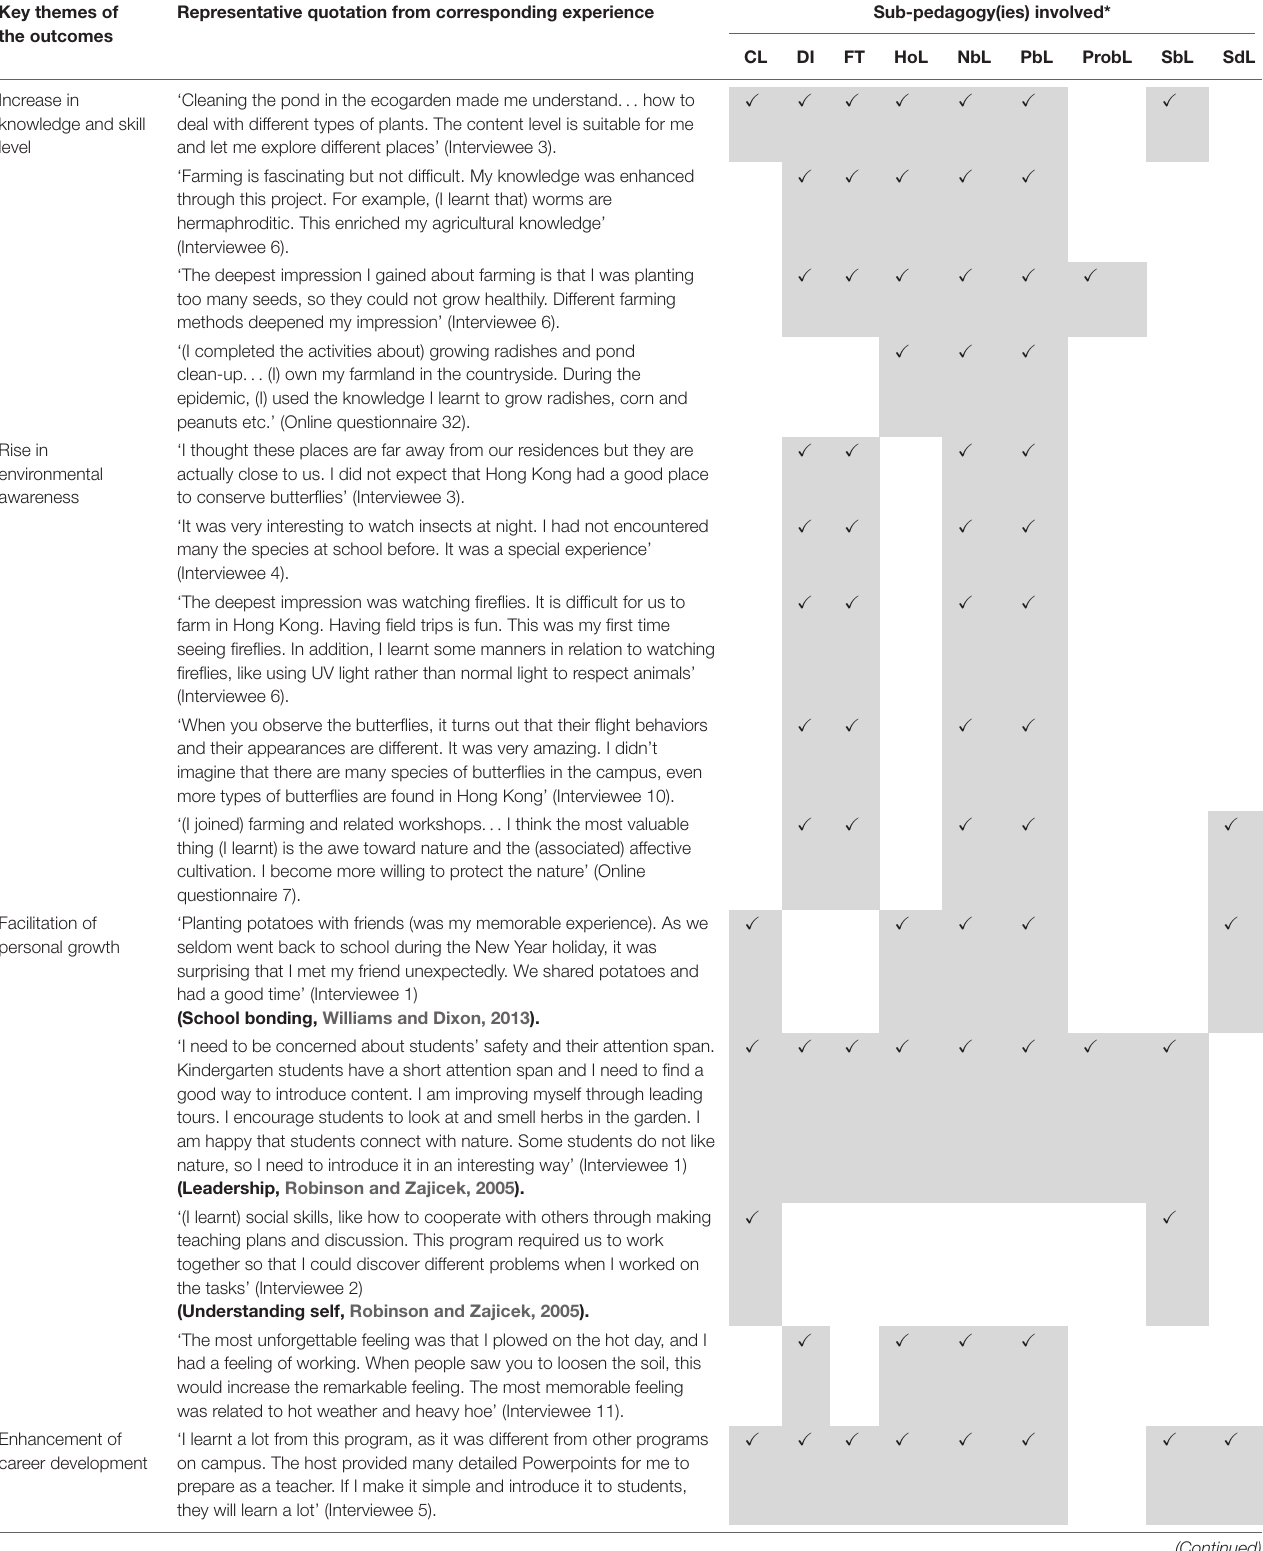
TABLE 1 | The exemplary quotes from the themes identified in the study with the associating sub-pedagogies being matched. Key themes of Representative quotation from corresponding experience Sub-pedagogy(ies) involved* the outcomes Increase in knowledge and skill level